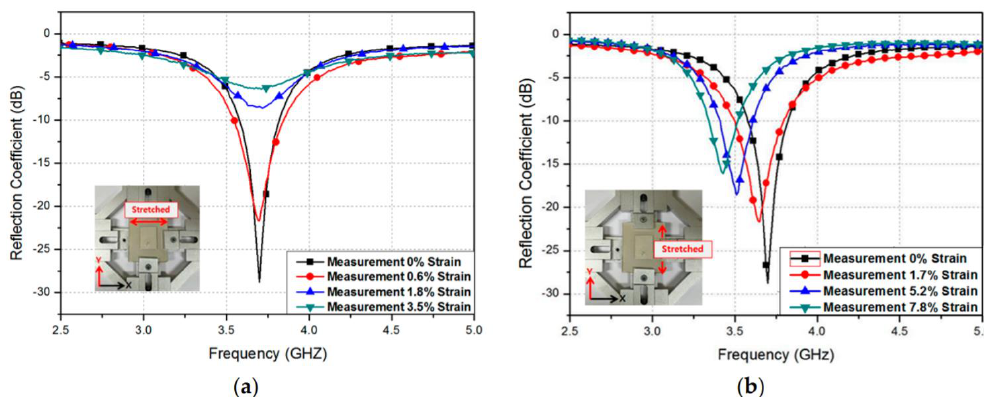
Figure 23. Measured reflection coefficients at different patch: ( a ) widths; and ( b ) lengths [78].